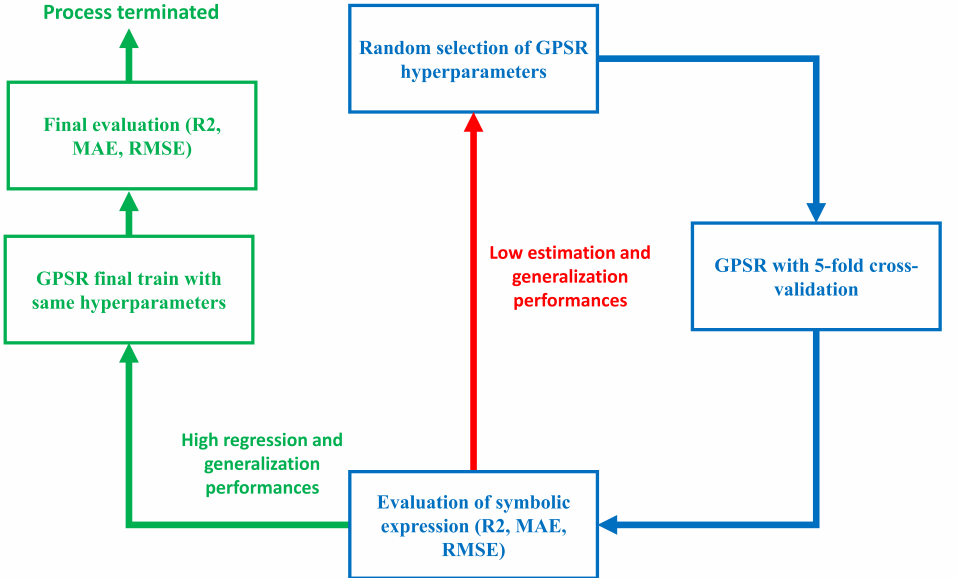
Figure 7. The flowchart of GPSR with random hyperparameter search and 5-fold cross